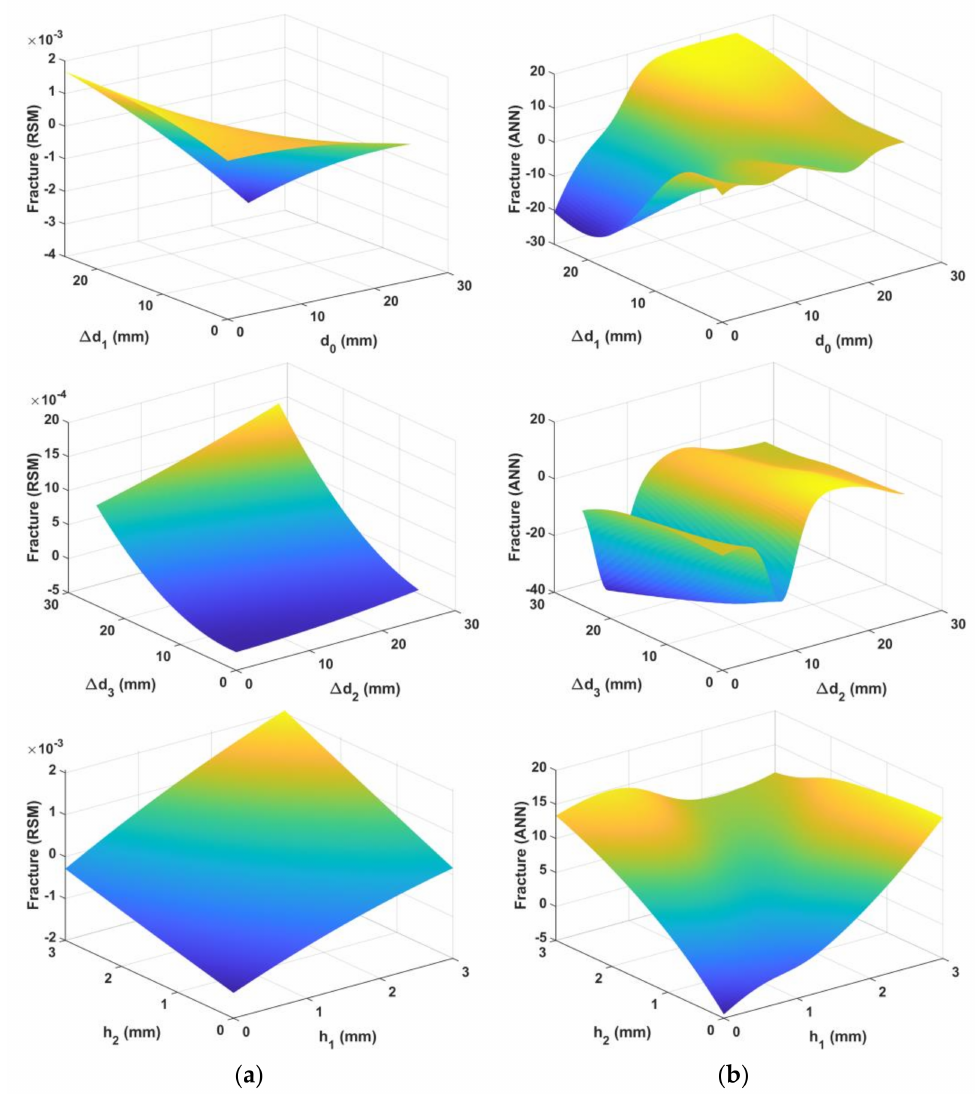
Figure 13. Predicted surface for fracture objectives based on design variables: ( a ) quadratic response surface, ( b ) artificial neural